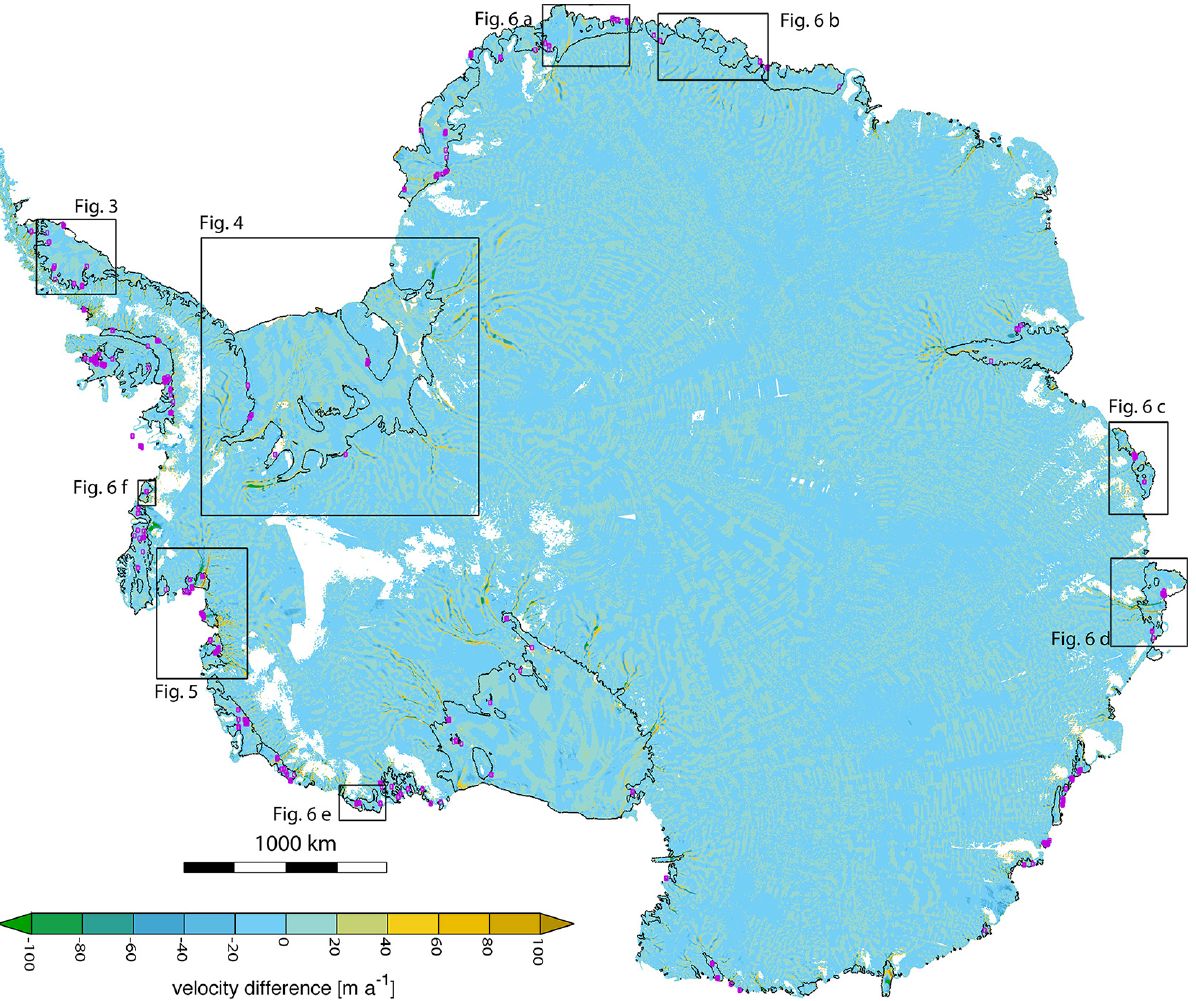
Figure 1. Difference of ice velocity magnitudes (simulated minus observed) over the Antarctic ice sheet. The result is based on the T geometry accounting for complementary information on pinning points. White areas over ice-covered areas indicate regions without velocity information. Pink squares indicate observed grounding line locations not included in Bedmap2 and further away than 5km from grounded areas in Bedmap2 (PIN5). The black contour line delineates the floating shelves. Black rectangles indicate locations of